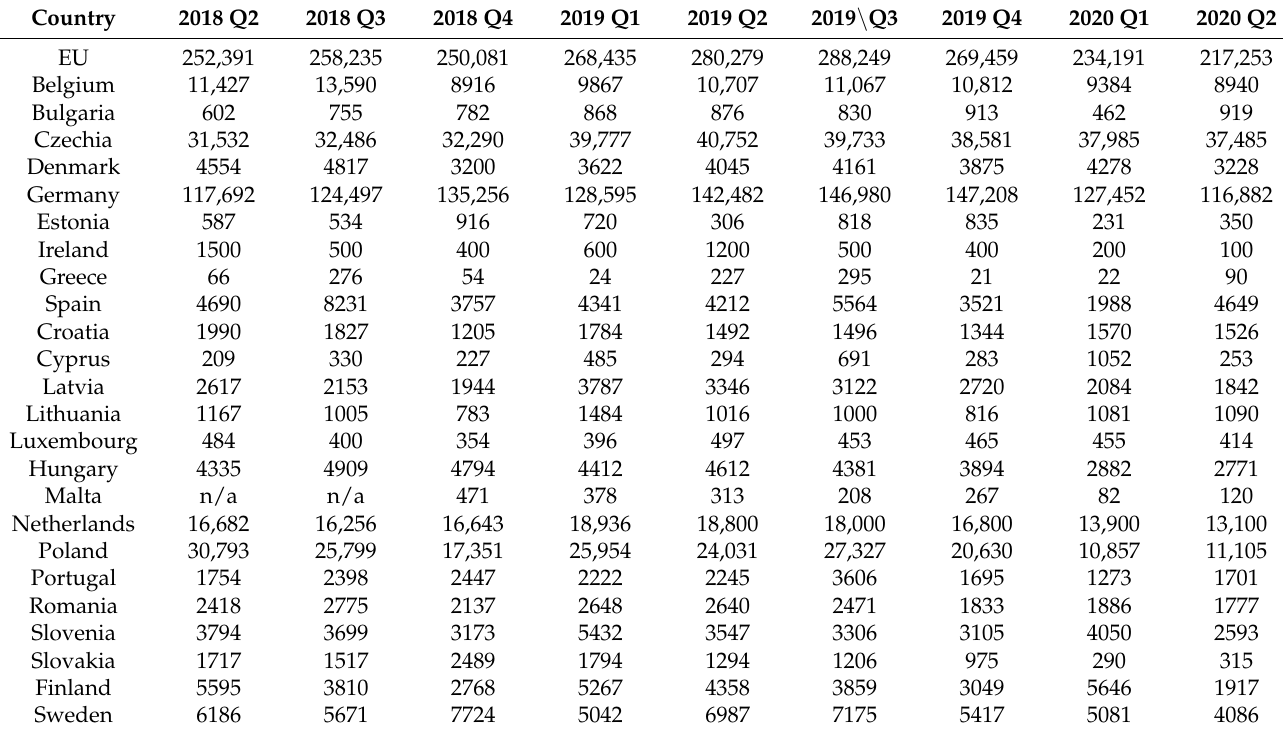
Table 3. Number of job vacancies in construction-quarterly data (the table is structured by authors upon open-source data collected from